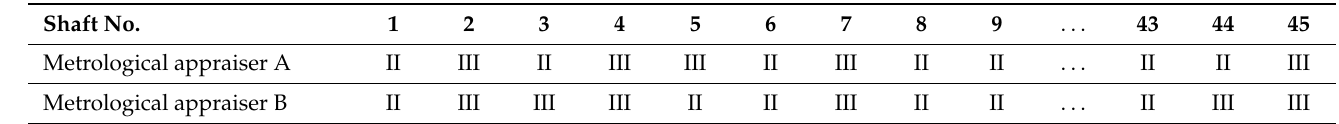
Table 11. Classification of measured values into groups with respect to the tolerance field (tolerance zone and space), metrological appraisers A and